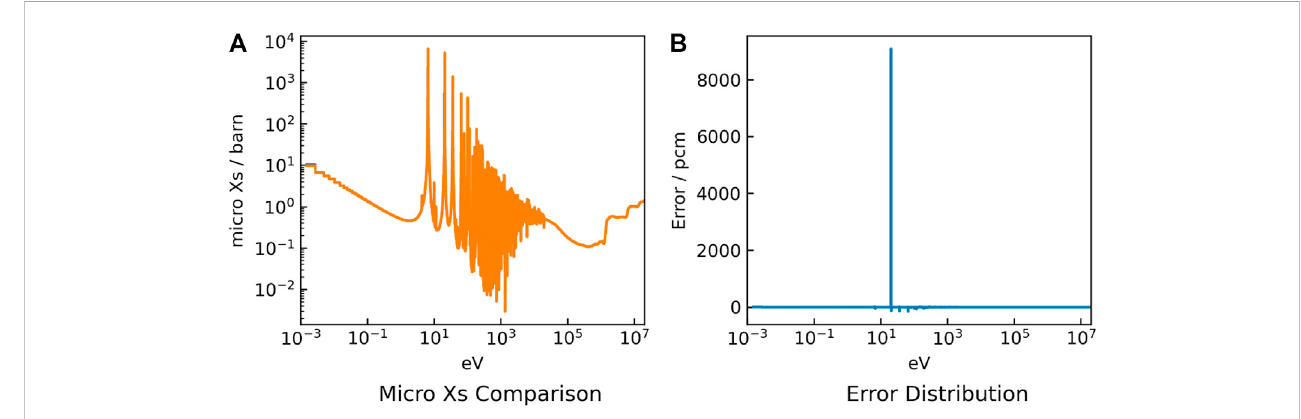
FIGURE 3 238 U absorption cross section results (A) and errors (B) for the UO 2 problem with thermal spectrum.